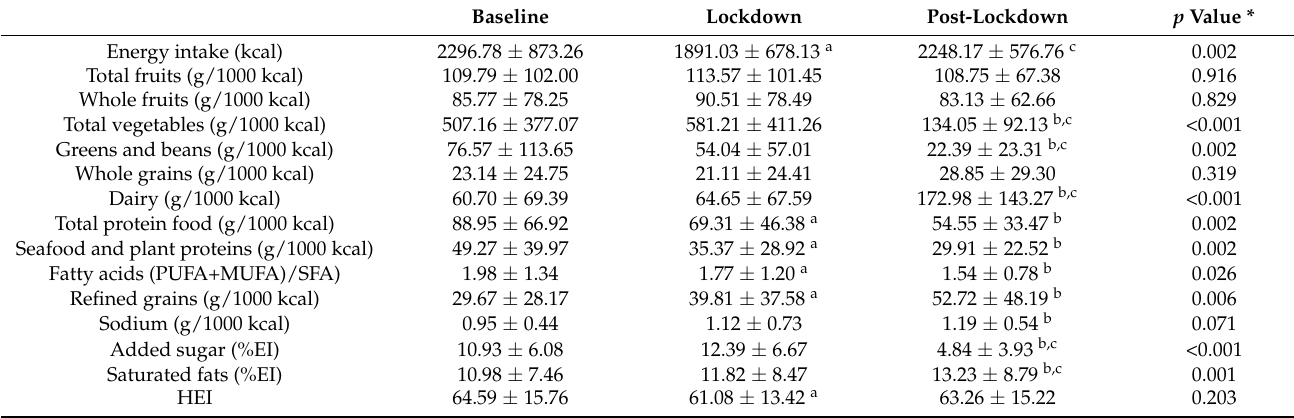
Table 3. Energy Intake and Healthy Eating Index and its Categories at Baseline, During Lockdown and Post-Lockdown. Baseline Lockdown